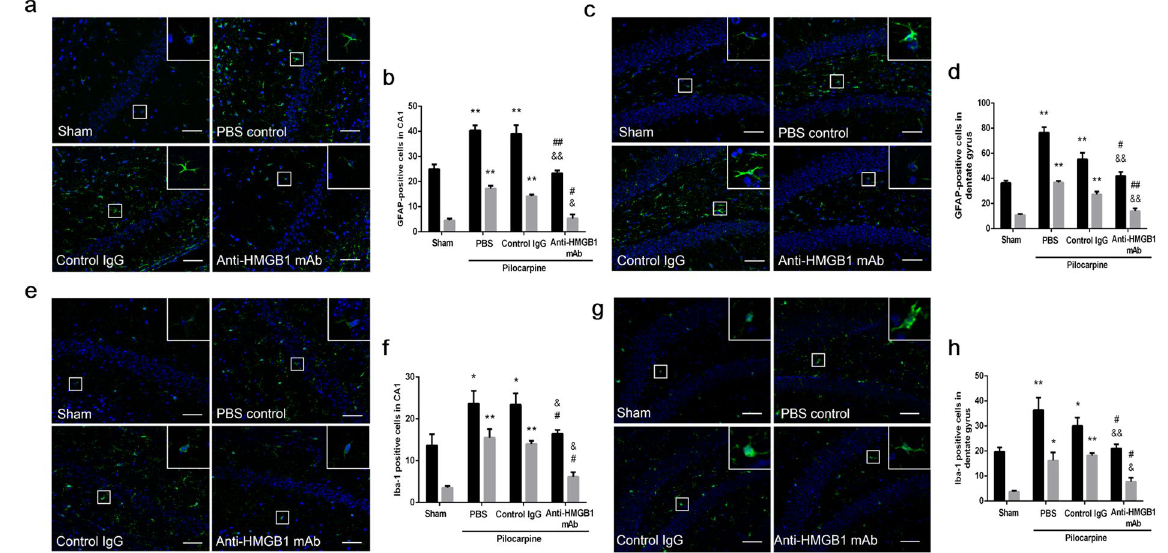
Figure 5. Morphological changes of astrocytes and microglia cells in the hippocampus and dentate gyrus of mice under acute status epilepticus. Anti-HMGB1 mAb, control IgG or PBS was immediately administered to mice reached Racine stage 5 and sacrificed 4 h later. The brain sections were stained with anti-GFAP (green) and DAPI (blue). The total number and activated astrocytes in the CA1 ( a ) and dentate gyrus ( c ) were counted in each group and the results are shown as the means ± SEM of 8 mice. Black bar showed the total number of astrocytes and the gray bar showed the number of activated astrocytes. ** p < 0.01 compared with the sham control. & p < 0.05, && p < 0.01 compared with the PBS control. # p < 0.05, ## p < 0.01 compared with the control IgG group ( b ). ** p < 0.01 compared with the sham control. && p < 0.01 compared with the PBS control. # p < 0.05, ## p < 0.01 compared with the control IgG group ( d ). The brain sections were stained with anti-Iba1 (green) and DAPI (blue). The total number and active/amoeboid Iba1-positive cells were counted in the hippocampus ( e ) and dentate gyrus ( g ) in each group and the results are shown as the means ± SEM of 8 mice. * p < 0.05, ** p < 0.01 compared with the sham control. & p < 0.05 compared with the PBS control. # p < 0.05 compared with the control IgG group ( f ). ** p < 0.01, ** p < 0.05 compared with the sham control. & p < 0.05, && p < 0.01 compared with the PBS control. # p < 0.05 compared with the control IgG group ( h ). Scale bars equal 50 μ